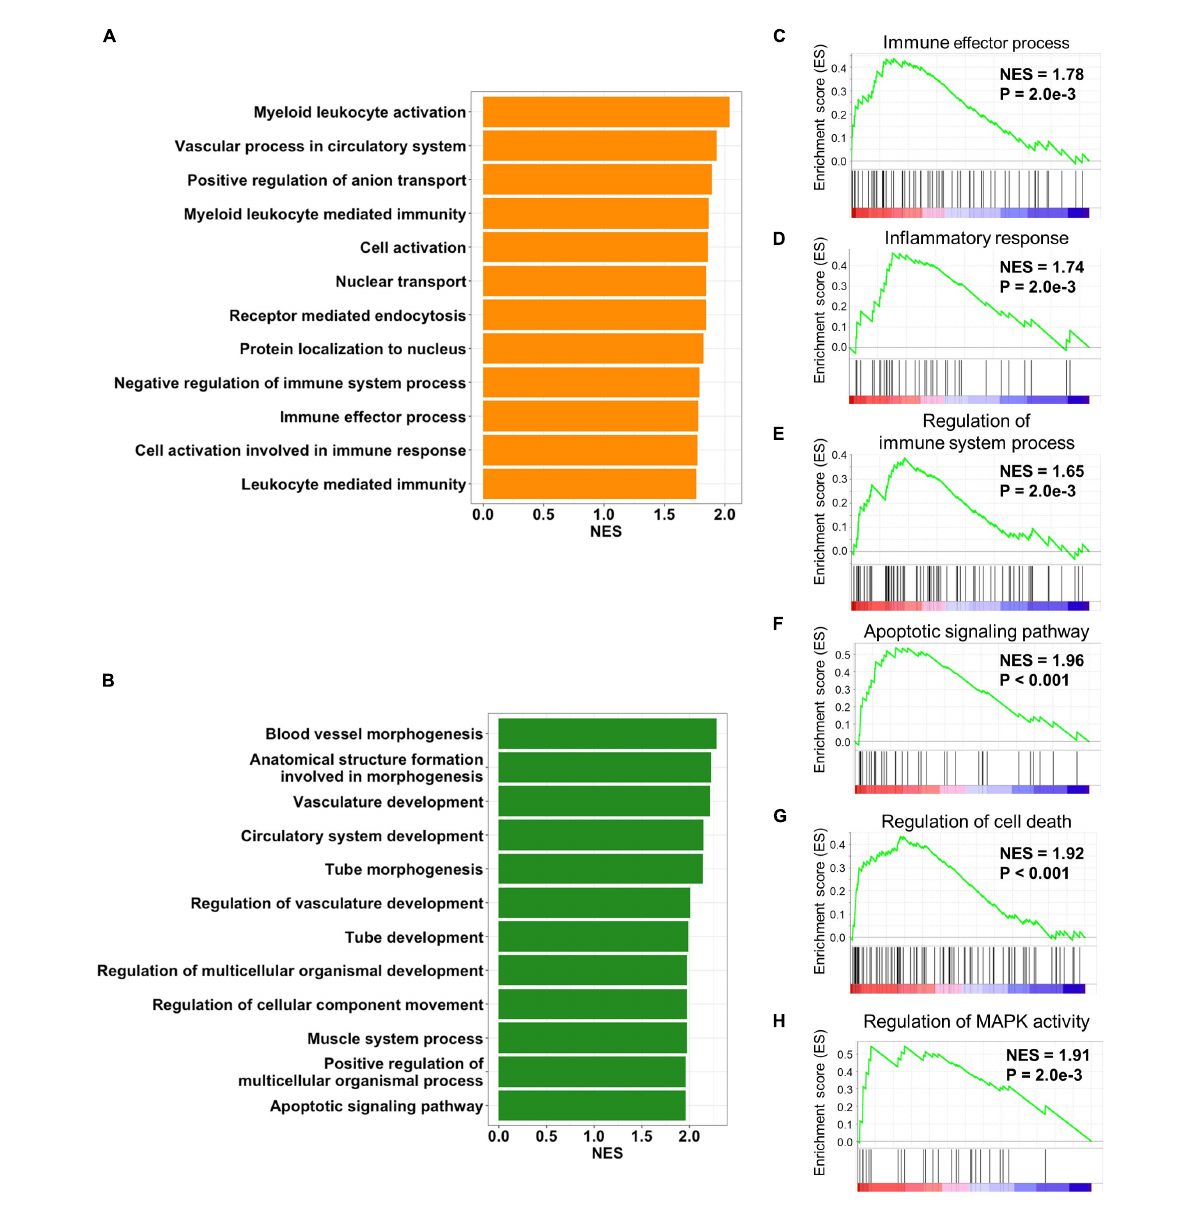
FIGURE4 Biological processes of preserved modules. Bar plots represent p -values of biological process of gene ontology from (A) orange and (B) green modules. The top 12 biological processes with the most overlapped genes between the annotated gene list and module genes are displayed. The orange module was positively enriched with (C) the immune effector process, (D) inflammatory response, and (E) regulation of the immune system process. The green module was positively enriched with (F) the regulation of MAPK activity, (G) the regulation of cell death, and (H) the apoptotic signaling